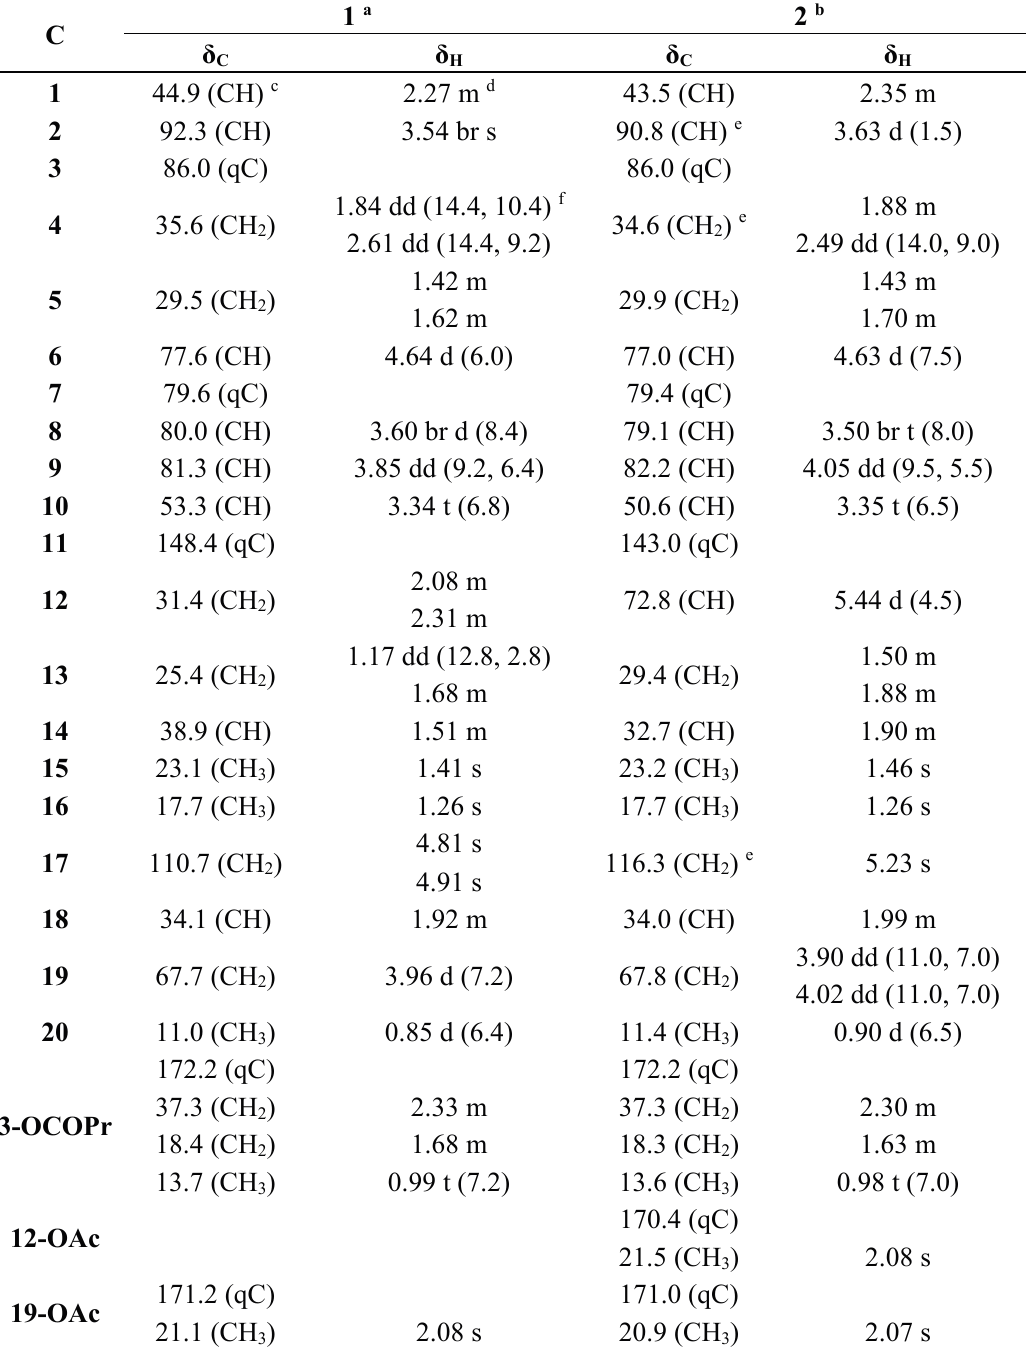
Table 1. 13 C and 1 H NMR data for compounds 1 – 2